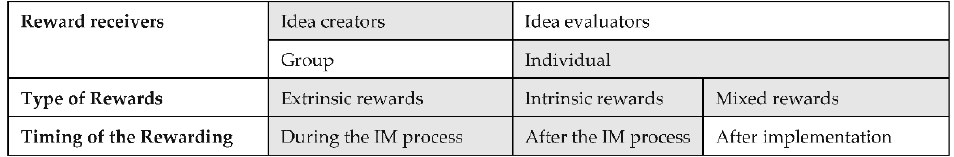
Figure 12. Selected Elements for the